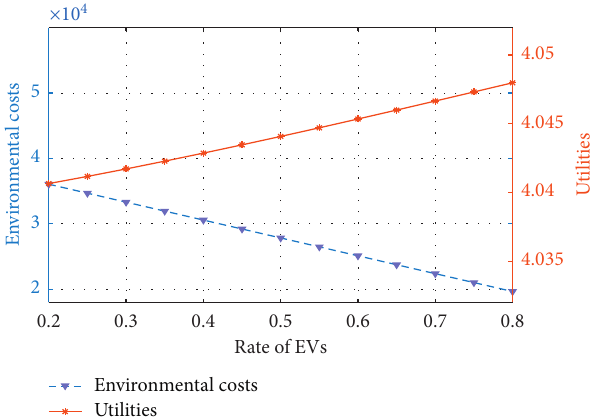
Figure 5: Impacts of EV’s market penetration rate on environ- mental costs and utilities.